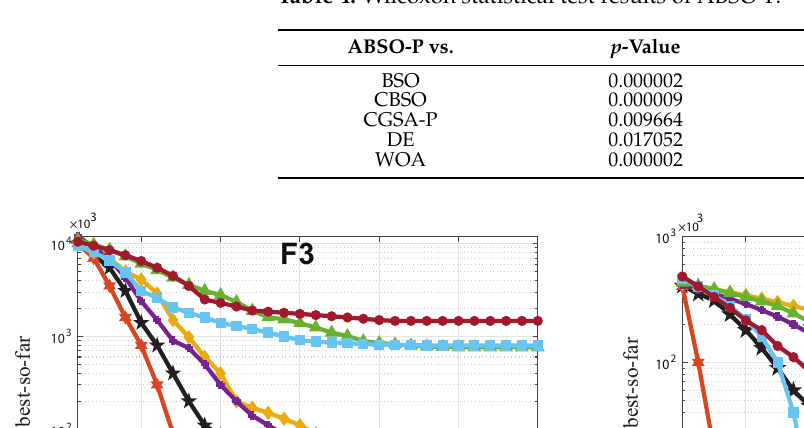
Table 4. Wilcoxon statistical test results of ABSO-P.